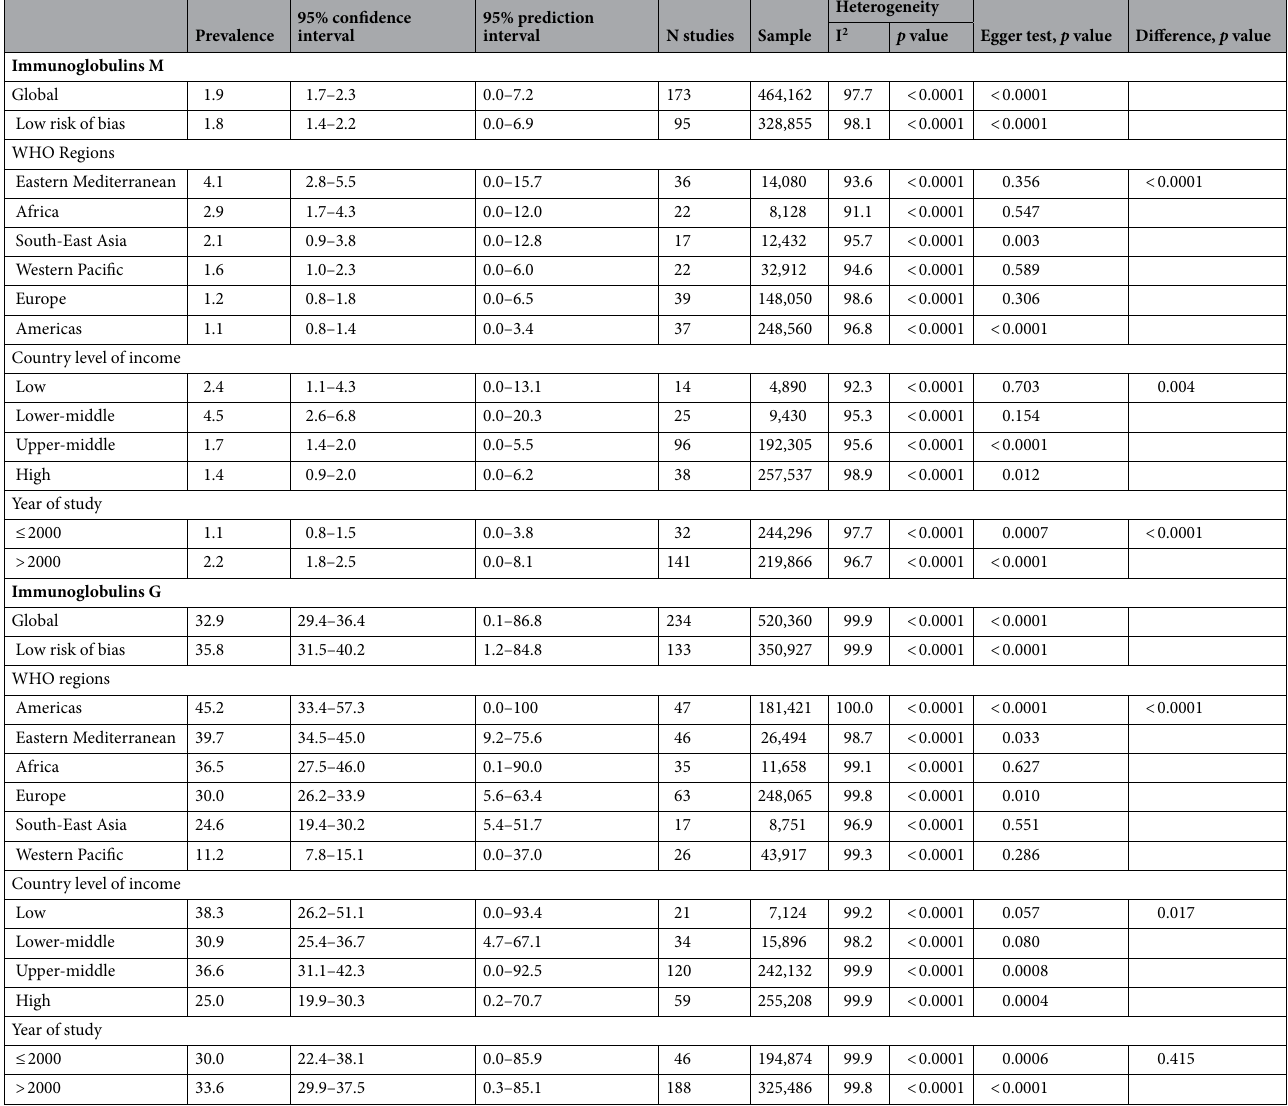
Table 1. Meta-analysis seroprevalence of Toxoplasma gondii in the global and regional population of pregnant